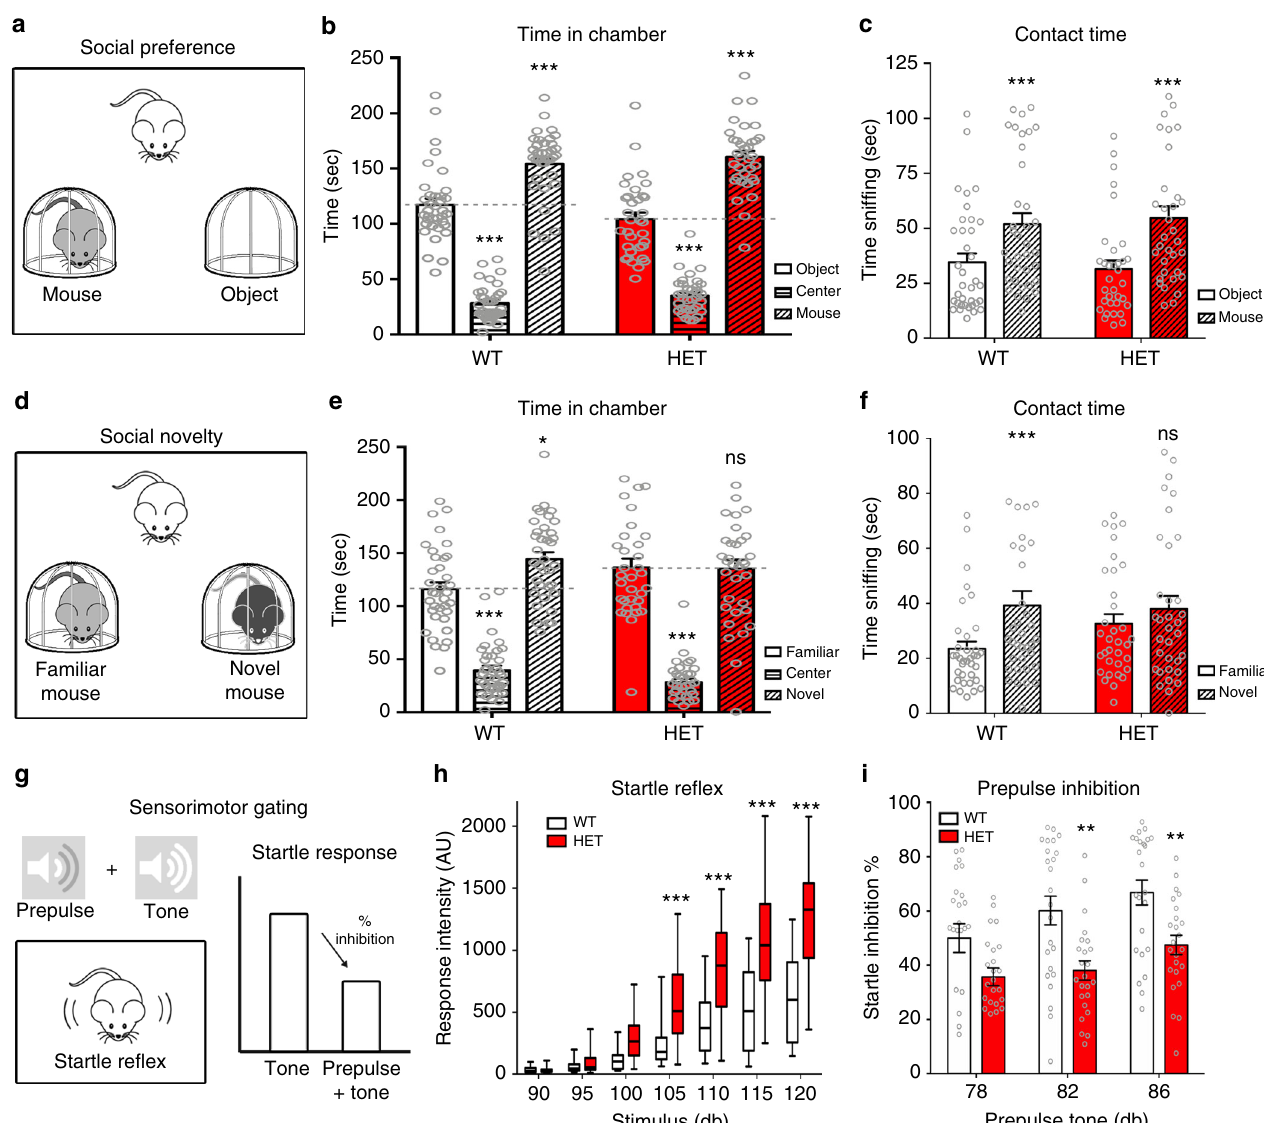
Fig. 4 Sociability and sensorimotor phenotype of NUAK1 HET mice. a 3-chamber sociability assay design. b , c Quanti fi cation of time spent in each chamber ( b ) and contact time with the mouse or the empty cage ( c ) did not reveal any social de fi cit in NUAK1 HET mice. Data: Average± SEM. N WT = 36, N HET = 34. Analysis: 2-way ANOVA with Bonferroni ’ s multiple comparisons. *** p < 0.001. d Social novelty assay design. e , f Quanti fi cation of time spent in chambers ( e ) and contact time with a familiar and a novel mouse ( f ). Data: Average± SEM. N WT = 36, N HET = 34. Analysis: 2-way ANOVA with Bonferroni ’ s multiple comparisons. ns: p > 0.05, * p < 0.05, *** p < 0.001. g Sensorimotor gating assay and measurement of the startle response. The startle re fl ex intensity ( h ) and % inhibition of the startle response upon pre-stimulation with a milder tone ( i ) showed altered response in NUAK1 HET. Data represents min, max, median, 25 th , and 75 th percentile ( h ) or average ± SEM ( i ). N WT = 24, N HET = 24. Analysis: 2-way ANOVA with Bonferroni ’ s multiple comparisons. ** p < 0.01, *** p < in NUAK1 + / − females compared to control WT littermates (Supplementary Fig. 6D-E, see fi gure legend for statistical results). Finally, the optimal InterStimulus Interval (ISI) was similar between WT and NUAK1 + / − mice, and the PPI was impaired at all ISI examined, indicating that the de fi cit in PPI does not result from an abnormality in the temporal function of the startle re fl ex (Supplementary Fig. 6A). Taken together, our results indicate that NUAK1 heterozygosity induces a de fi cit in the PPI pointing to a sensory gating defect most likely due to a strong increase in the initial startle response. NUAK1 cell-autonomously controls axon branching . Given the embryonic lethality characterizing the NUAK1 − / − constitutive